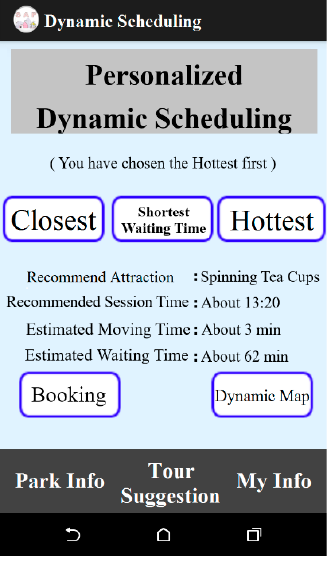
Figure 9. Experimental results of the Hottest First strategy.